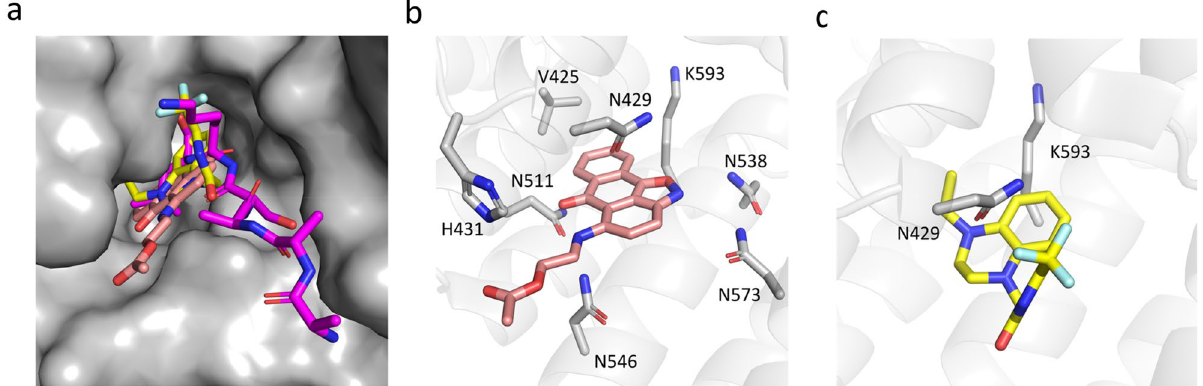
Figure 4. Putative binding modes (docking poses) of compounds 2 and 6 at the PTS1 binding pocket of PEX5. ( a ) Surface representation of the PTS1 binding site (grey). Compounds 2 (pink) and 6 (yellow) overlay with the SKL motif of the PTS1 (magenta—PDB code:3CVP) ( b , c ) docking poses of compounds 2 and 6 , respectively. Residues important for binding are highlighted as